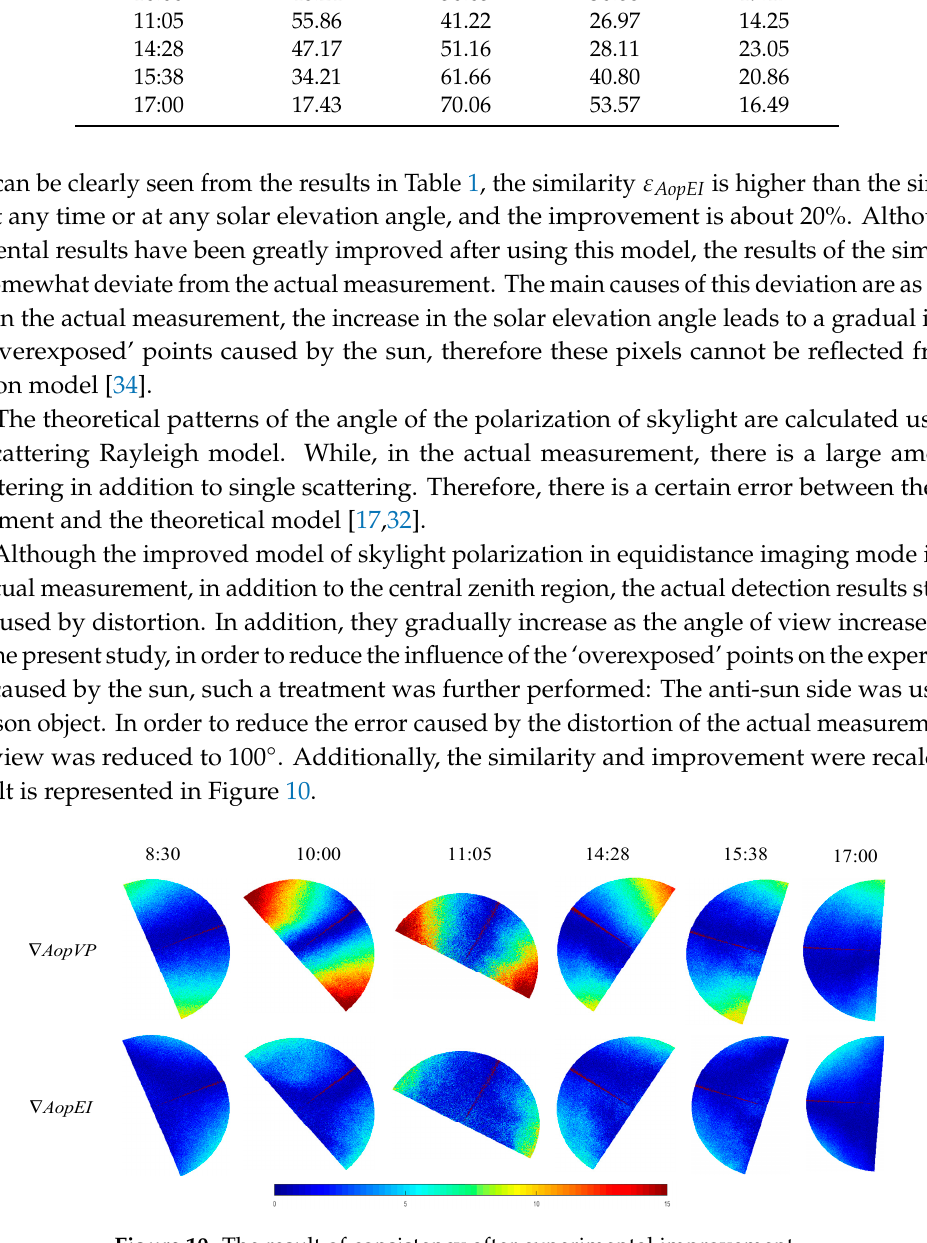
Figure 10. The result of consistency after experimental improvement.